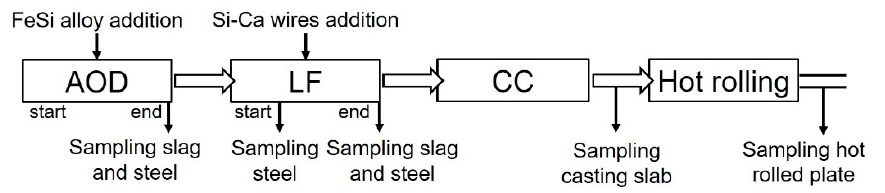
Figure 1. Schematic layout of the steelmaking process and sampling occasions.